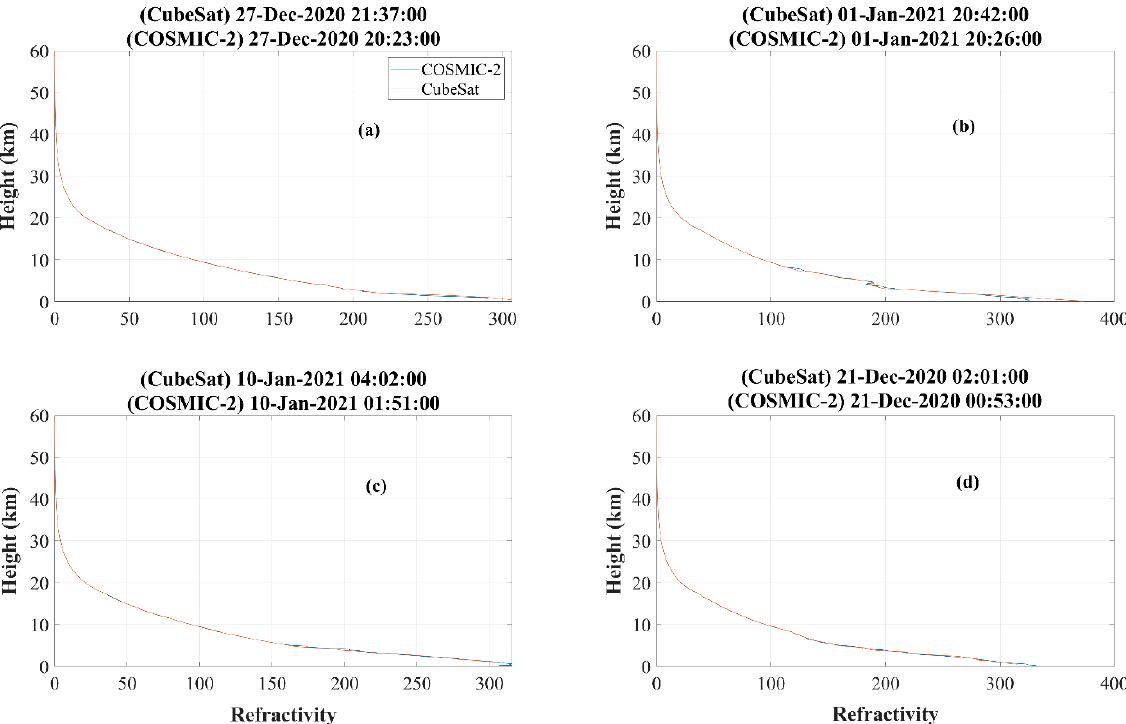
Figure 15. Comparing CubeSats and COSMIC-2 in terms of the refractivity and height. The profiles related to each date are provided in subfigures ( a – d ).